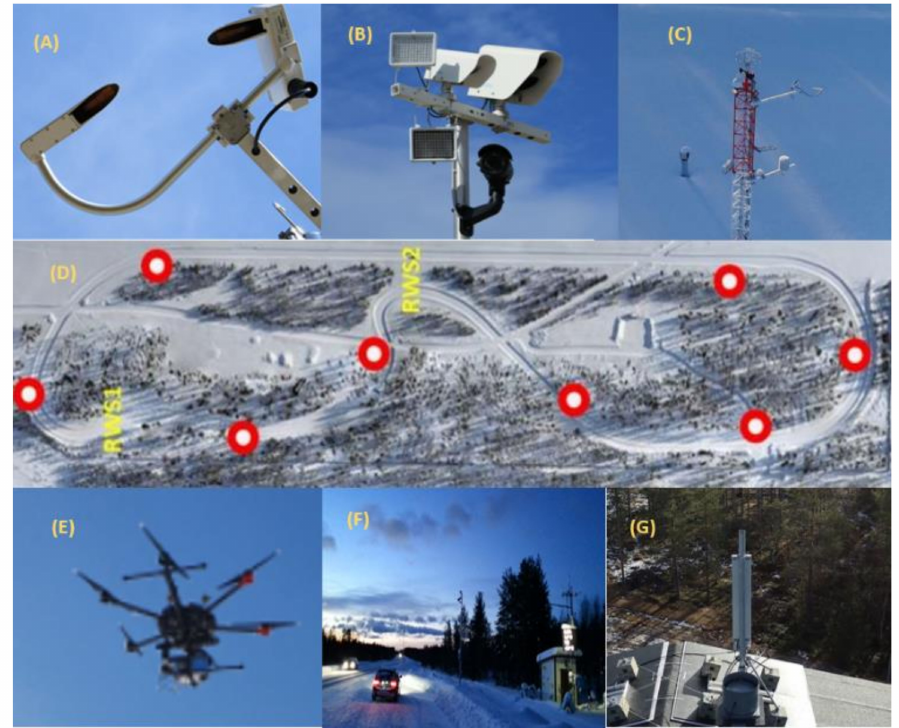
Figure 5. ( A ) Visibility and weather detector; ( B ) surface state sensor; ( C ) road weather station and camera; ( D ) test track; ( E ) test track equipped with IoT sensors (i.e., red spots); ( E ) drone; ( F ) field measurements in a real environment; ( G ) 5GTN road weather